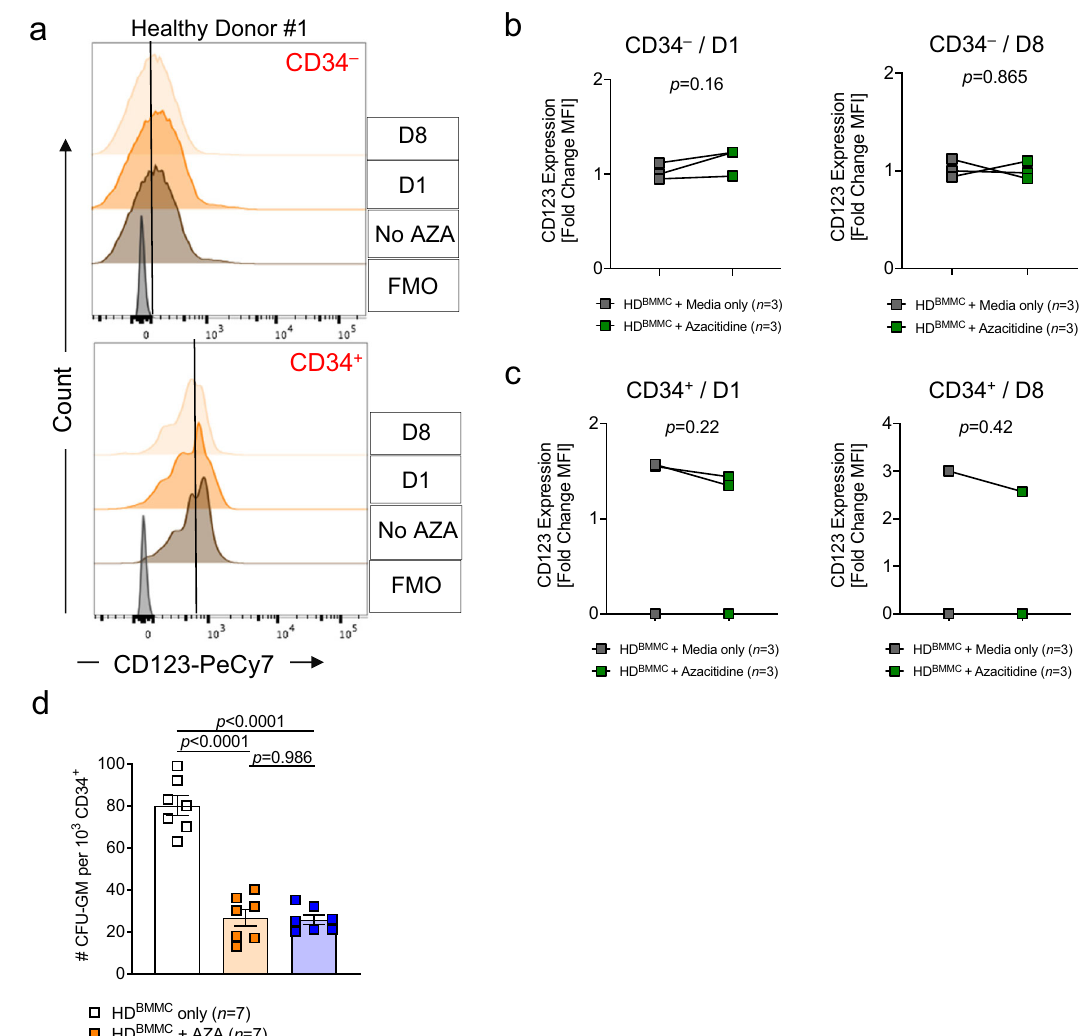
Fig. 6 Impact of Azacitidine pre-treatment followed by anti-CD123 CAR T cell exposure on hematopoietic progenitor cell development. a Representative fl ow cytometry-based analysis of CD123 expression on CD34 + and CD34 − cells from a HD following culture in the absence or presence of 1 µ M AZA for 1 or 8 days. Histograms depict staining with anti-human CD123 Ab (PeCy7) compared to the FMO control. Scatter plots showing the expression of CD123 on primary HD b CD34 − and c CD34 + cells represented as a fold change of MFI with respect to MFI of untreated controls ( n = 3) on days 1 and 8 following culture with 1 µ M AZA ( n = 3). d CFU-GM colonies were scored using an inverted microscope following a 14-day co-culture in methocult supplemented with hSCF, IL-3, EPO, G-CSF, and GM-SCF. CD34 + HD BMMC was fi rst co-cultured in the presence or absence of 1 µ M AZA for 24 h. The following day the cells were washed. Untreated cells were cultured in media only ( n = 7) and treated cells were cultured in media only ( n = 7) or with anti-CD123 CAR Tc ( n = 7) at an E:T ratio of 1:1 for 6 h. The cell suspension was subsequently transferred and plated in methocult. Colony numbers are represented per 1000 plated cells. Data were pooled from three primary HD samples, each plated in at least duplicates. All graphed data are represented as mean ± SEM. p- values were calculated using two-sided unpaired student ’ s t -test (Mann – Whitney) ( b , c ) and two-sided one-way ANOVA (Tukey ’ s test) ( d